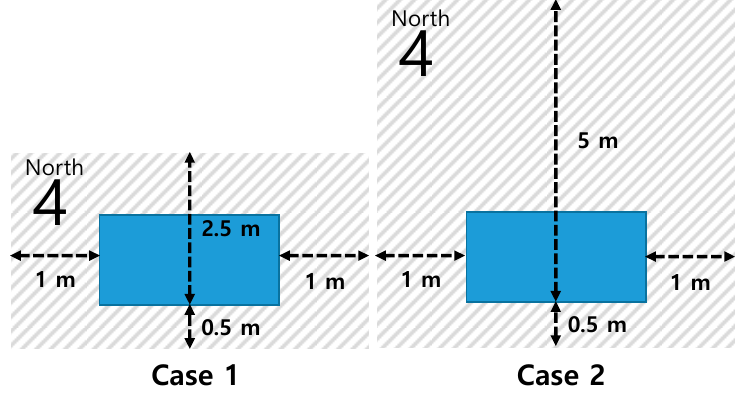
Figure 2. Plan view of each case at Testbed 1.